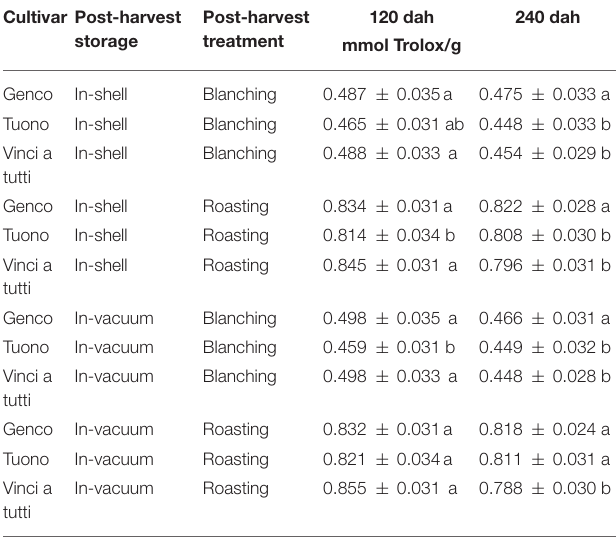
TABLE 5 | ORAC in the seed skin of three Italian almond cultivars at harvest and during in-shell and vacuum storage. Cultivar Post-harvest